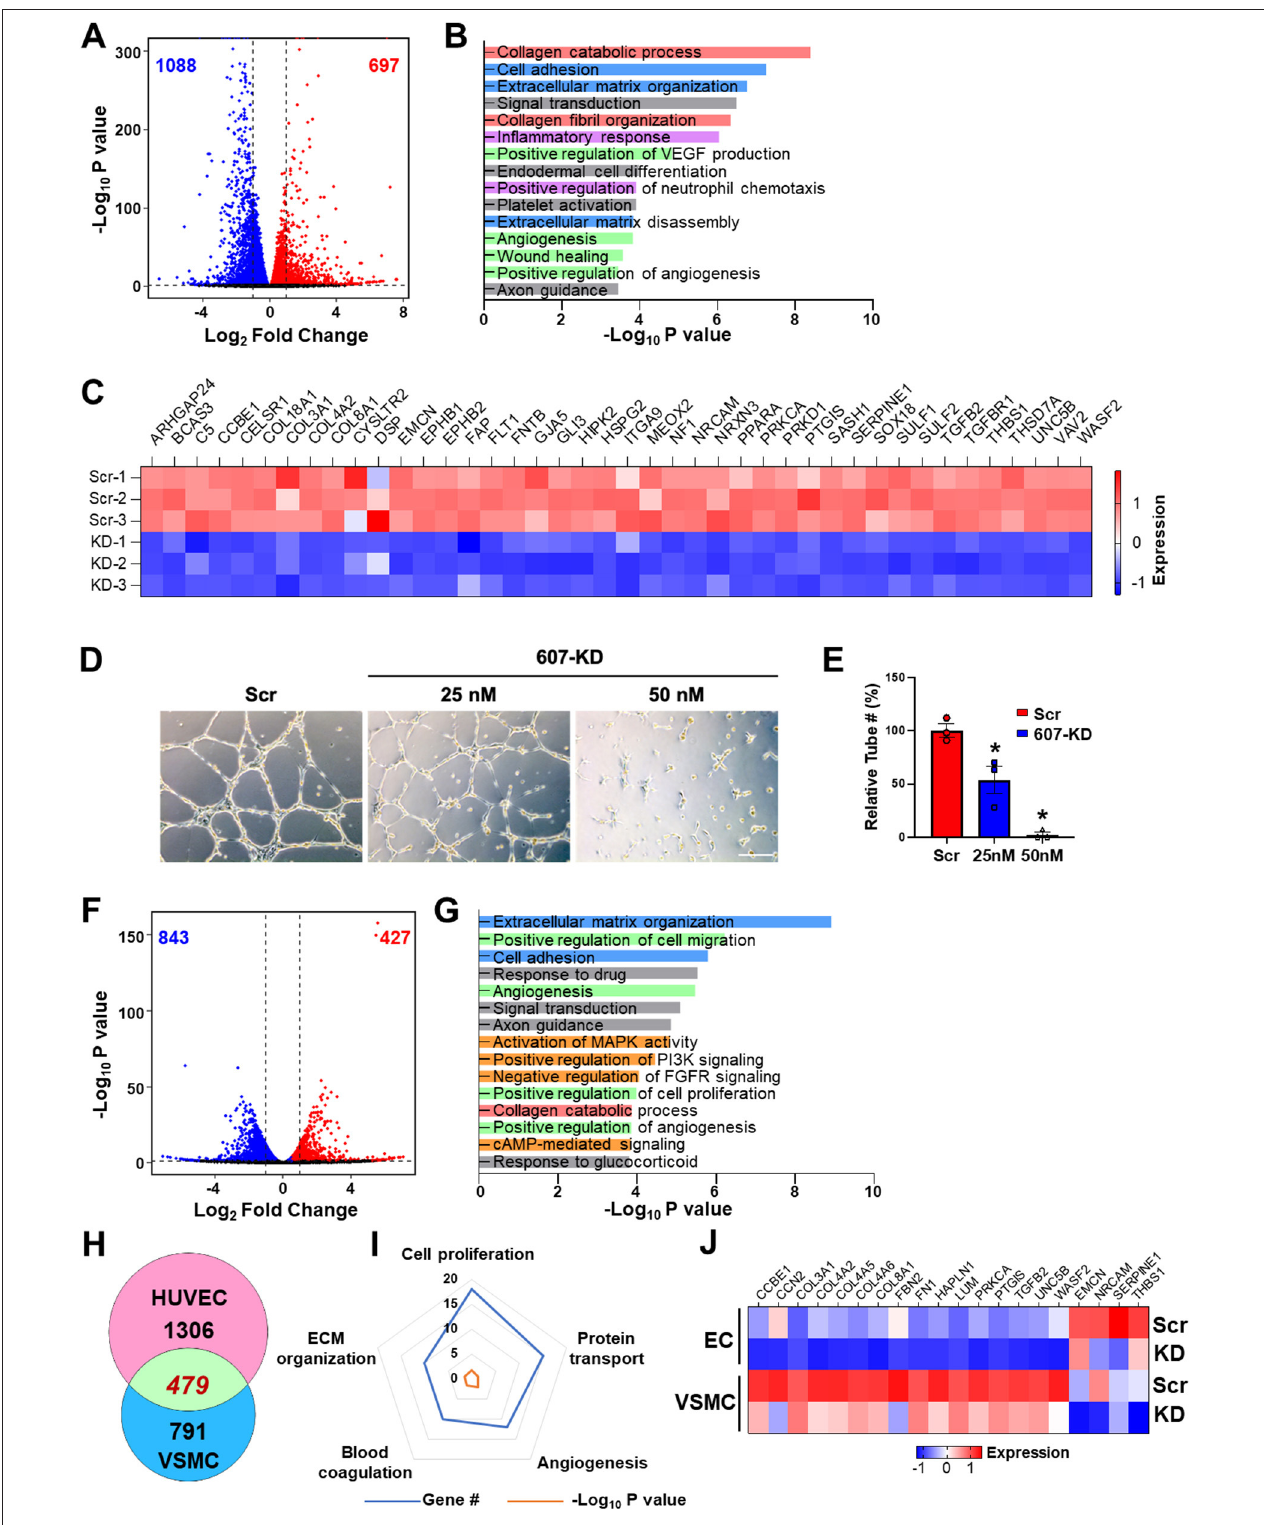
FIGURE 2 | LINC00607 regulates basal EC and VSMC function. (A) Volcano plot indicating the DEGs upon 607-KD in HUVECs. Red and blue dots represent significantly up-regulated and down-regulated genes (with P -value cut-off of 0.01). Vertical dotted lines correspond to 2-fold differences. (B) Pathway enrichment analyses of DEGs upon 607-KD in HUVECs. Top 15 GO terms ranked by fold enrichment score for both the down- and up-regulated DEGs. (C) Expression of select